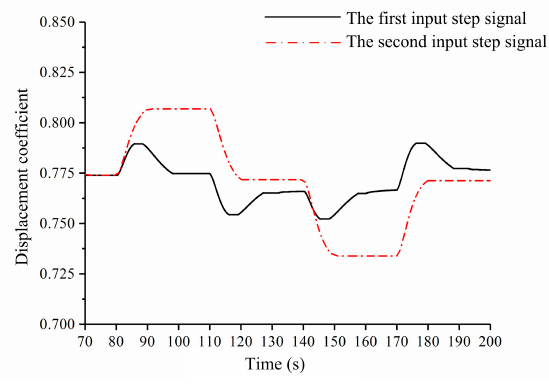
Figure 18. The closed loop motor displacement curve.